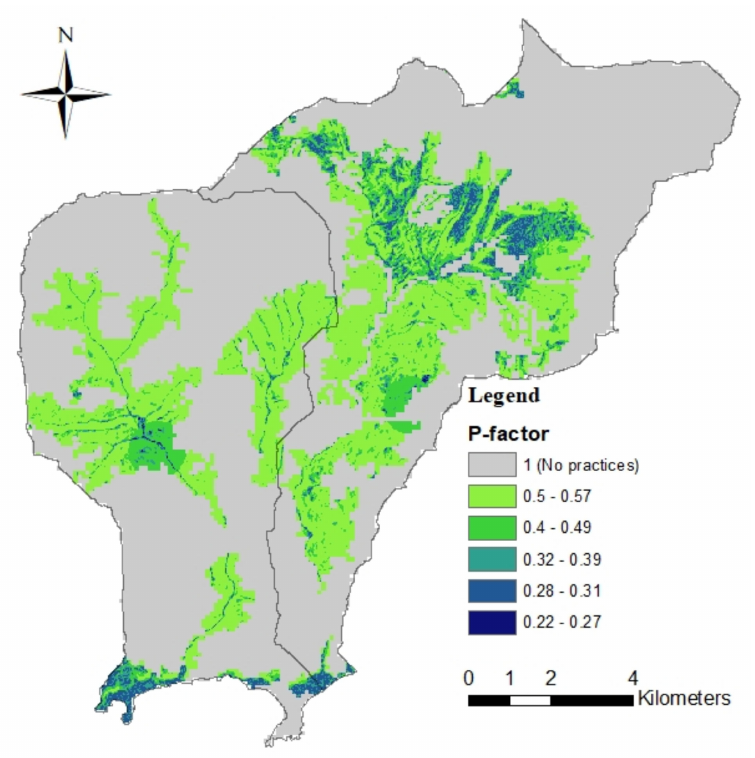
Figure 14. P-factor values for